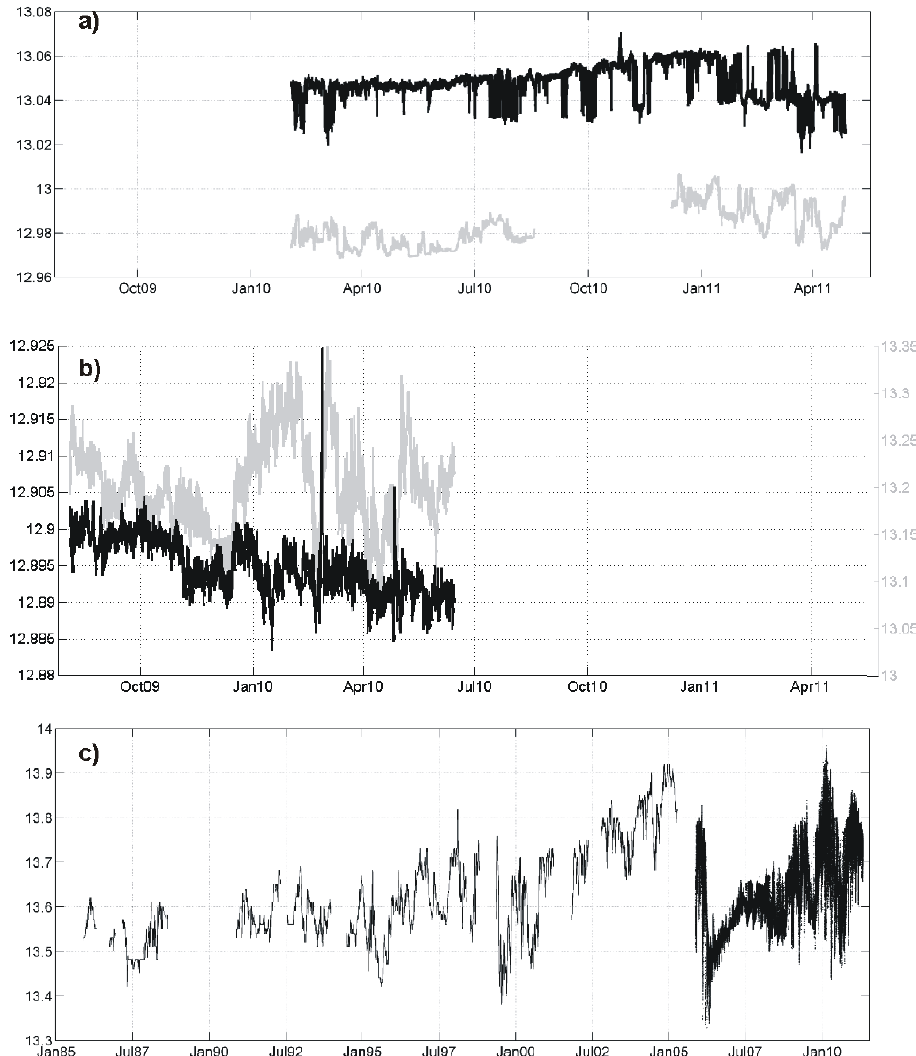
Fig. 10. θ time series in (a) TYR (black at 2524m, grey at 3380m), (b) DYF (black at 2000m, grey at 700m) and (c) CC (at 400m), where the first part of the record has been done with an Aanderaa current meter (precision of 0.05 ◦ C), while since late 2005 it has been replaced by a more precise SBE37 (0.001 ◦